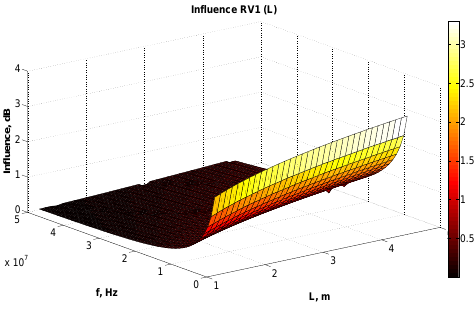
Figure 10: RV ranging from screening design.